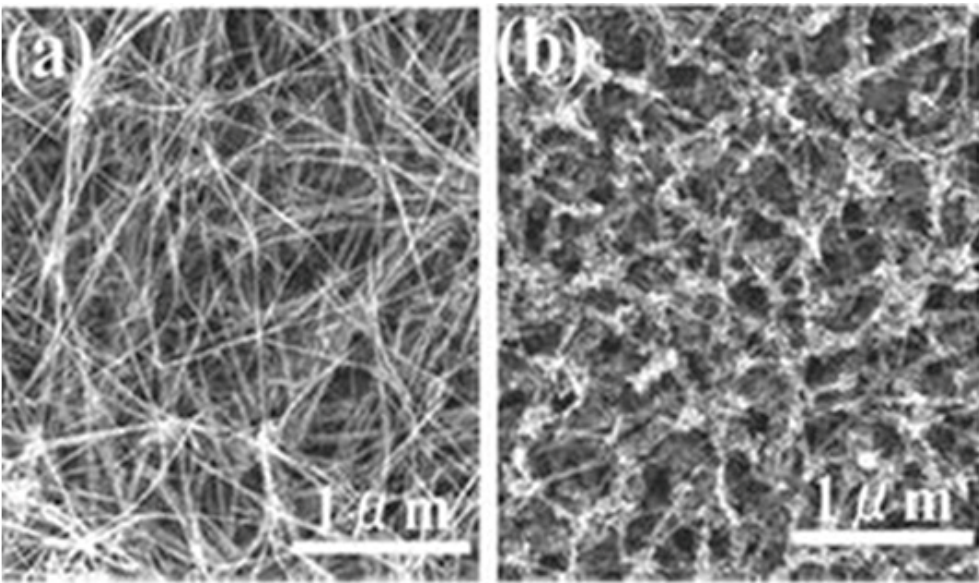
Figure 4. SEM images of MWCNTs ( a ) in the presence of and ( b ) in the absence of a magnetic field. Reproduced with permission from [29]. Copyright AIP, 2002.